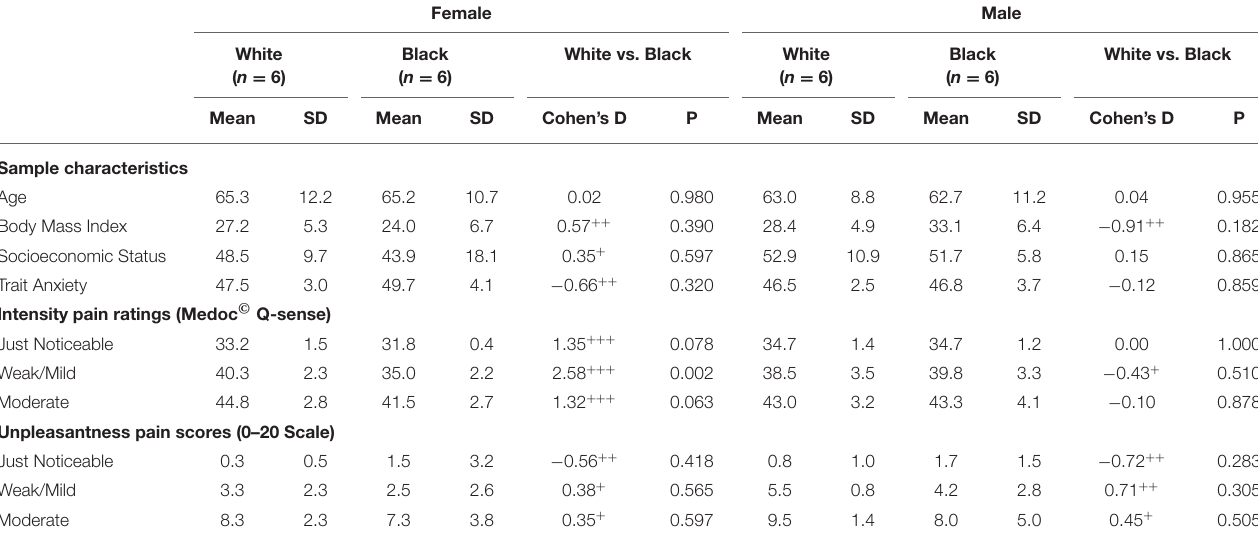
TABLE 1 | Sample characteristics and racial difference in pain by sex. Female Male White Black White vs. Black White Black White vs. Black ( n = 6) ( n = 6) ( n = 6) ( n = 6) Mean SD Mean SD Cohen’s D P Mean SD Mean SD Cohen’s D